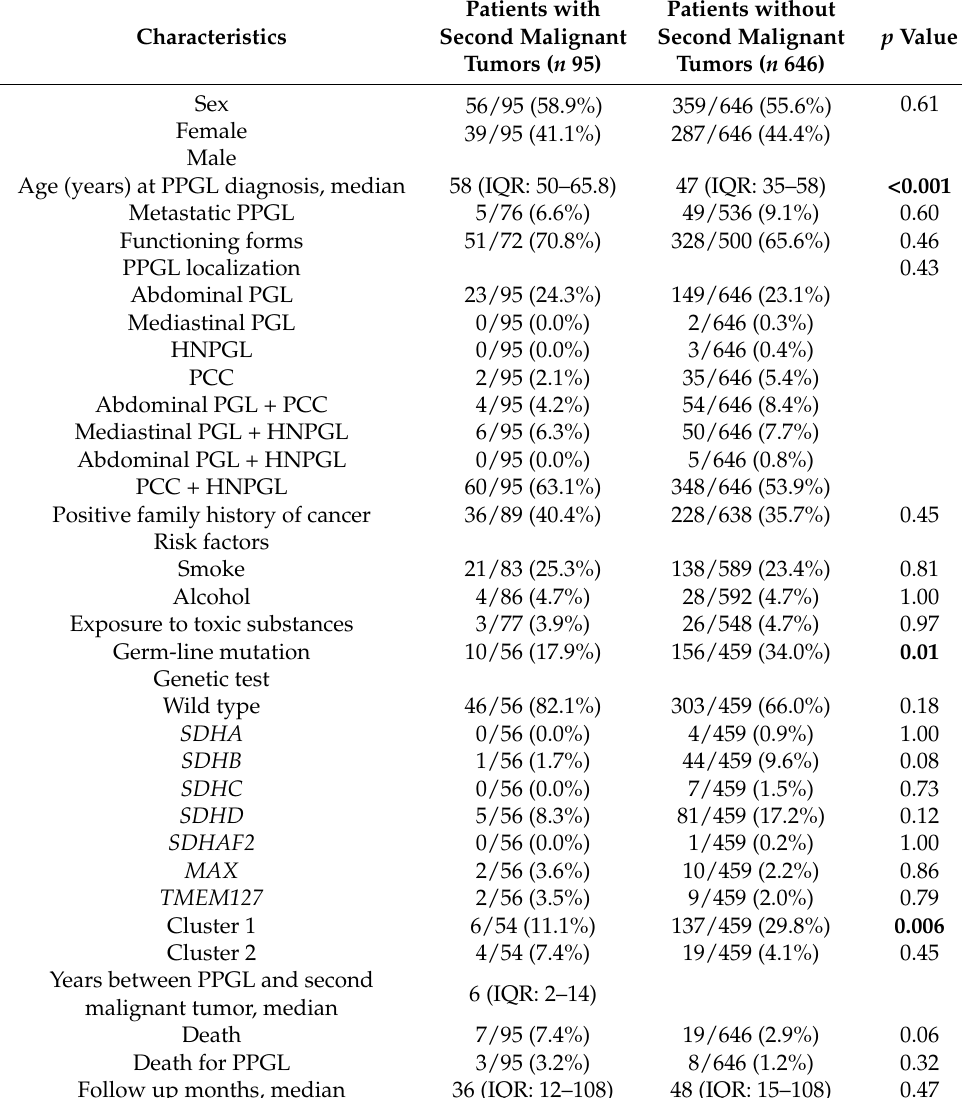
Table 3. Patient characteristics stratified by a second malignant